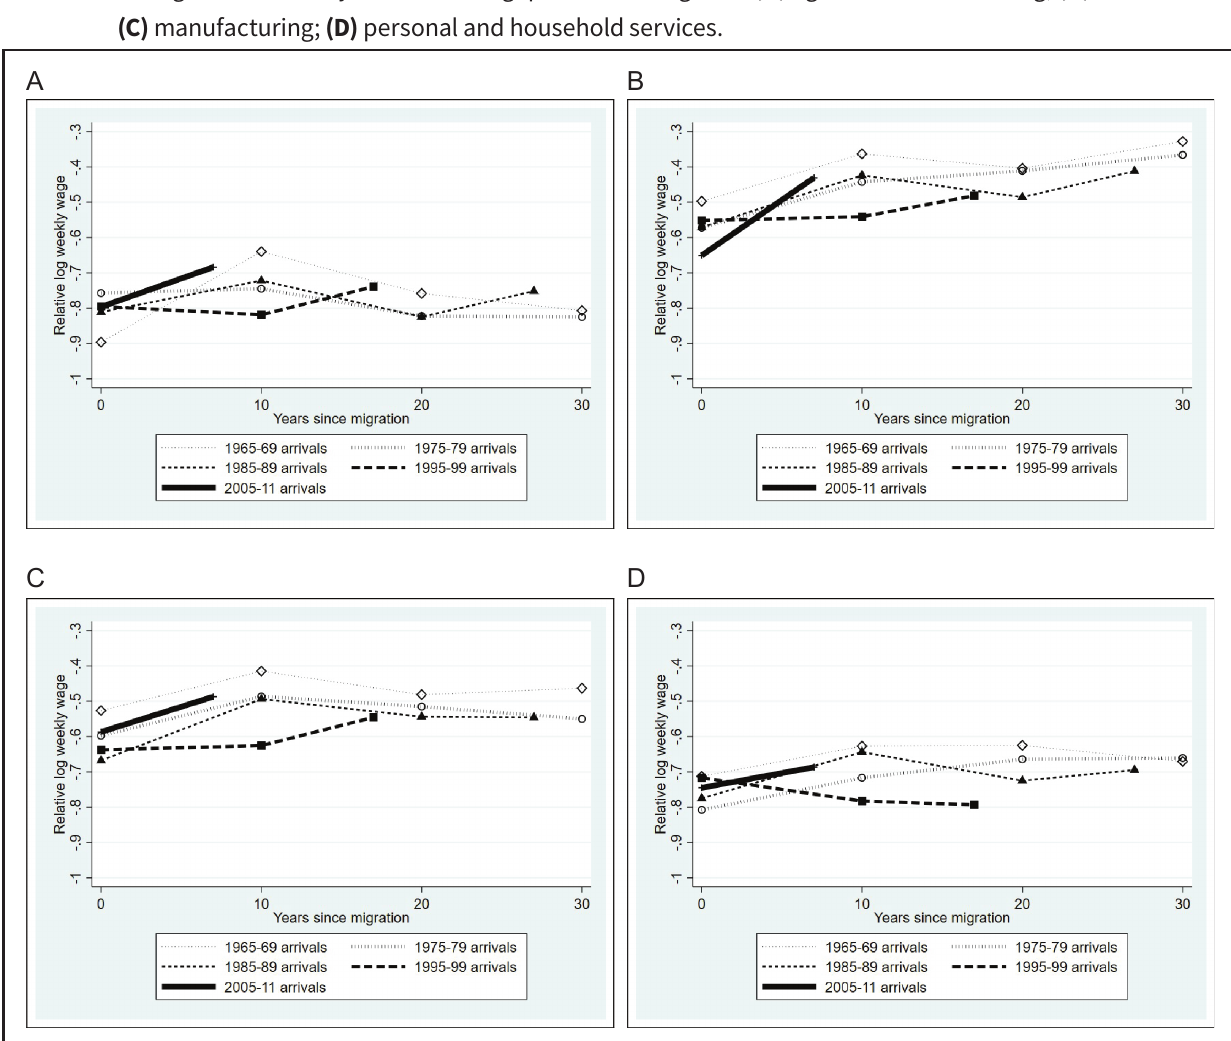
Figure 3 Age-adjusted convergences for the relative log weekly earnings of Mexican and Central American immigrant cohorts by sector: initial gaps and convergence. (A) agriculture and farming; (B) construction; (C) manufacturing; (D) personal and household